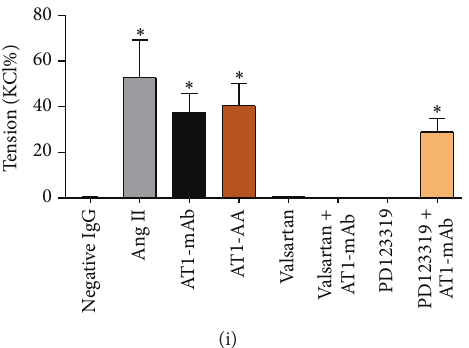
Figure 4: Biological activity of AT1-mAb was identified by isolated thoracic aorta ring technology. (a) Negative IgG isolated from healthy mouse serum; (b) Agonist of AT 1 R, Ang II; (c) AT1-mAb; (d) for AT1-AA exert the same effect on the contractile force of mouse thoracic aorta; (e) blocking agent for AT 1 R, valsartan; (f) valsartan + AT1-mAb; (g) blocking agent for AT 2 R, PD123319; (h) PD123319 + AT1-mAb; and (i) statistical graph of isolated vascular ring. ∗ 𝑃 < 0.05 versus negative IgG. Data represent the mean ± SEM; 𝑛 = 6